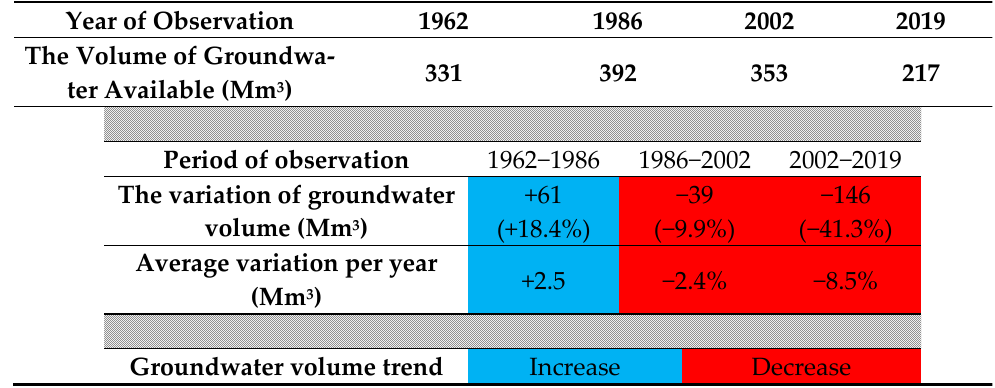
Table 2. Groundwater volume variations in the study area.